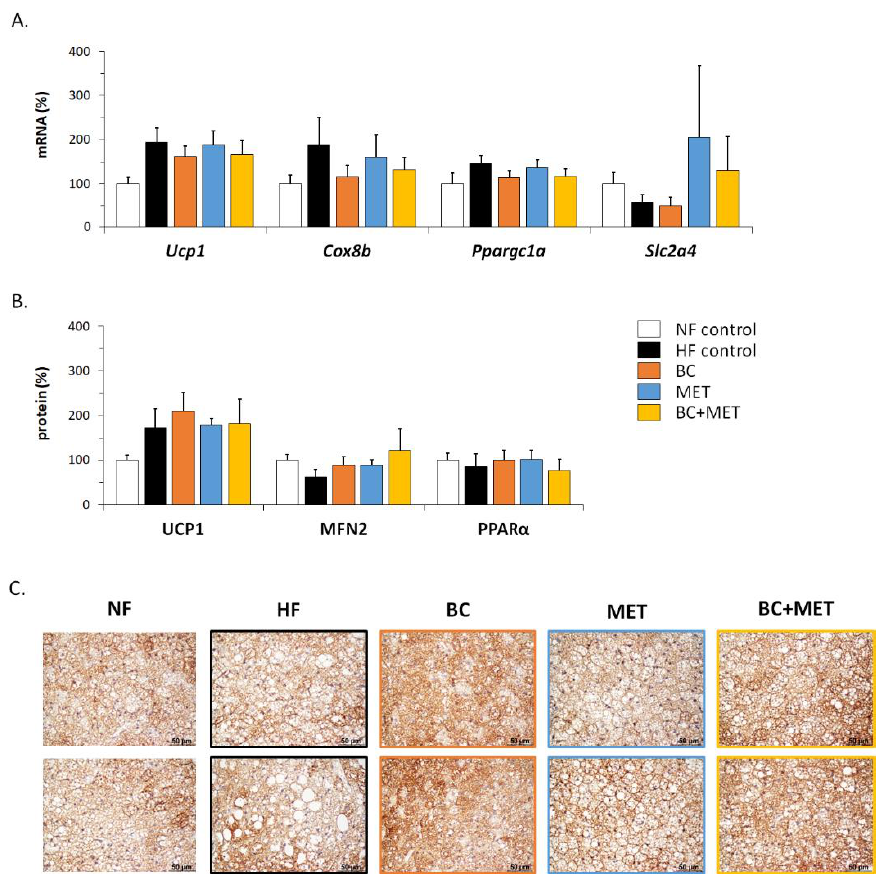
Figure 4. mRNA levels ( A ) and protein levels ( B ) of the indicated genes in BAT, and representative microphotographs of two mice per group illustrating BAT activation and uncoupling protein 1 (UCP1) immunostaining ( C ) at the end of the experiment. Obesity-prone mice were challenged with a high-fat diet for 4 weeks while receiving placebo (HF control) or being treated orally with BC (3 mg/kg/day), MET (100 mg/kg/day), or their combination (BC+MET); a fifth group received placebo and was kept on a normal-fat diet (NF control). Data are means ± SEM of five to nine animals per group and are expressed relative to the mean value of the NF control group, which was set to 100.